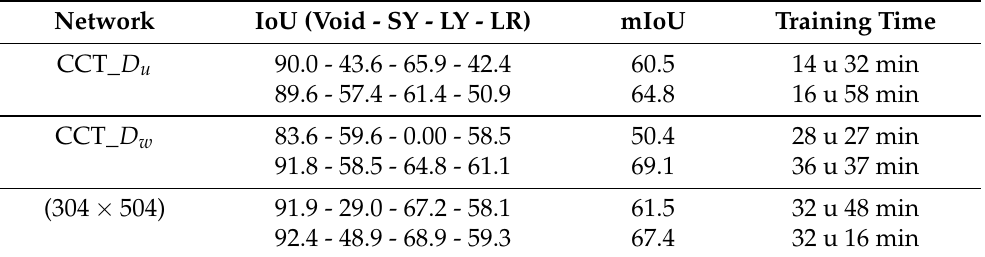
Table 5. The CCT training methods yield different results over multiple runs. We ran the same tests multiple times and found that the first few epochs are deterministic for the fitting of the model. CCT_ D u was trained on D l and D u ; CCT_ D w was trained on D l , D u and D w . The models were evaluated on D v